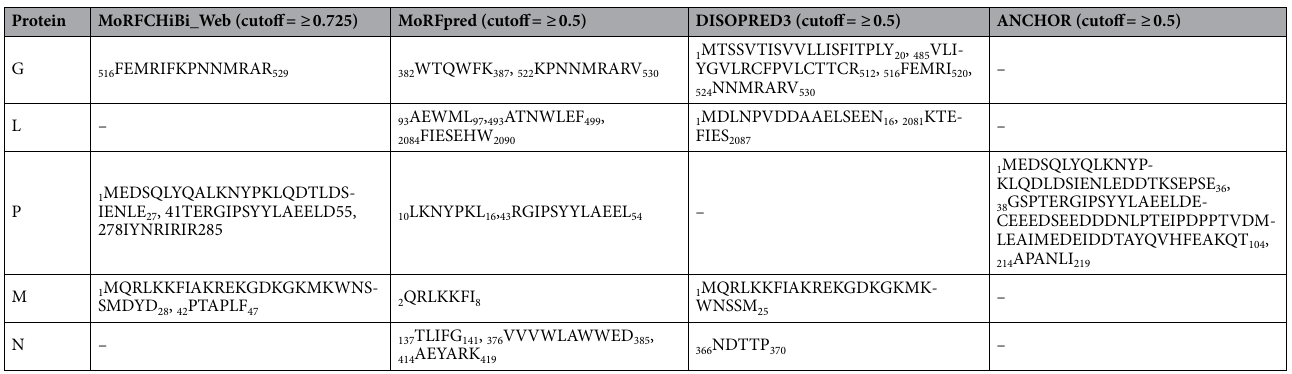
Table 2. Identified MoRF regions in CHPV